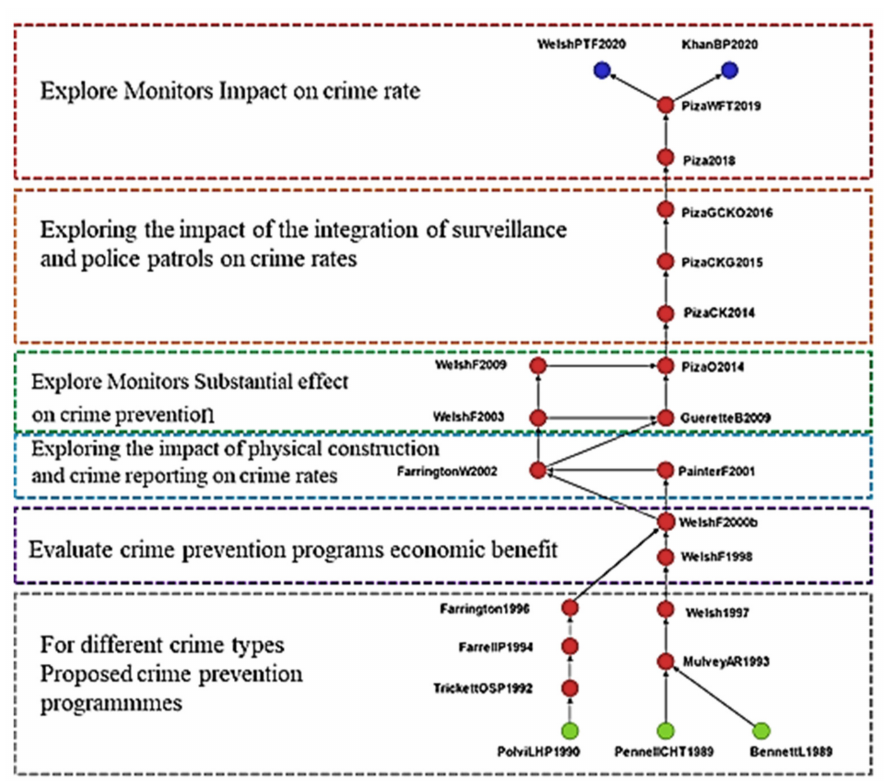
Figure 4. Key-route main path analysis of crime prevention (top to bottom). Exploring the effects of CCTV on crimes. Exploring the effects of interventions combining foot patrol and CCTV on crime rates. Exploring the effects of CCTV on crime prevention. Exploring the effects of physical infrastructure and crime reports on crime rates. Evaluating the costs and benefits of crime prevention strategies. Proposing prevention strategies for various types of